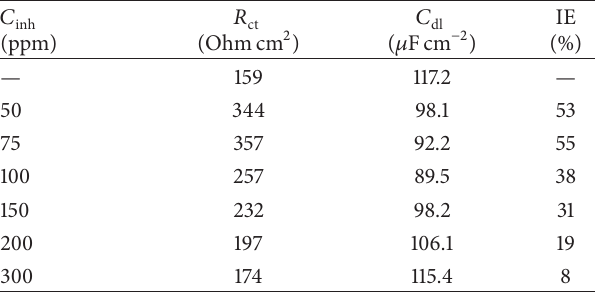
Table 2: Effect of Opuntia ficus-indica concentration on the 𝑅 𝐶 values obtained from EIS measurements at 25 ∘ C. dl